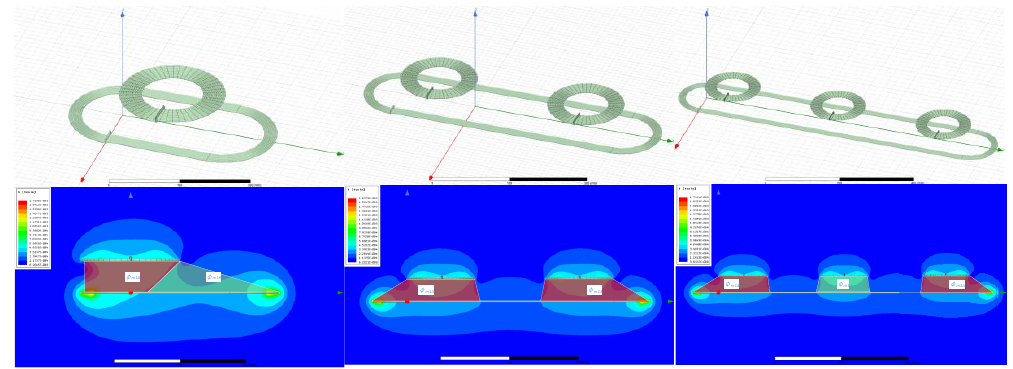
Figure 7. Coupling coefficient at different points.